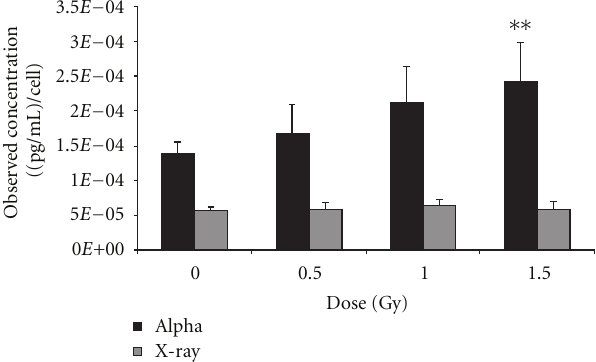
Figure 7: VEGF validation: twenty-four hours after exposure, cell culture supernatants were harvested from THP-1 cells exposed to 0, 0.5, 1.0, and 1.5 Gy of α -particle radiation and X-irradiation. 25uL of sample was used to determine levels of VEGF secretion using ELISA. ∗ represents P < 0 . 05, ∗∗ represents P < 0 . 01, and ∗∗∗ represents P < 0 . 001, n = 5 biological replicates performed in duplicate. Bars are plotted as cell count corrected means ±